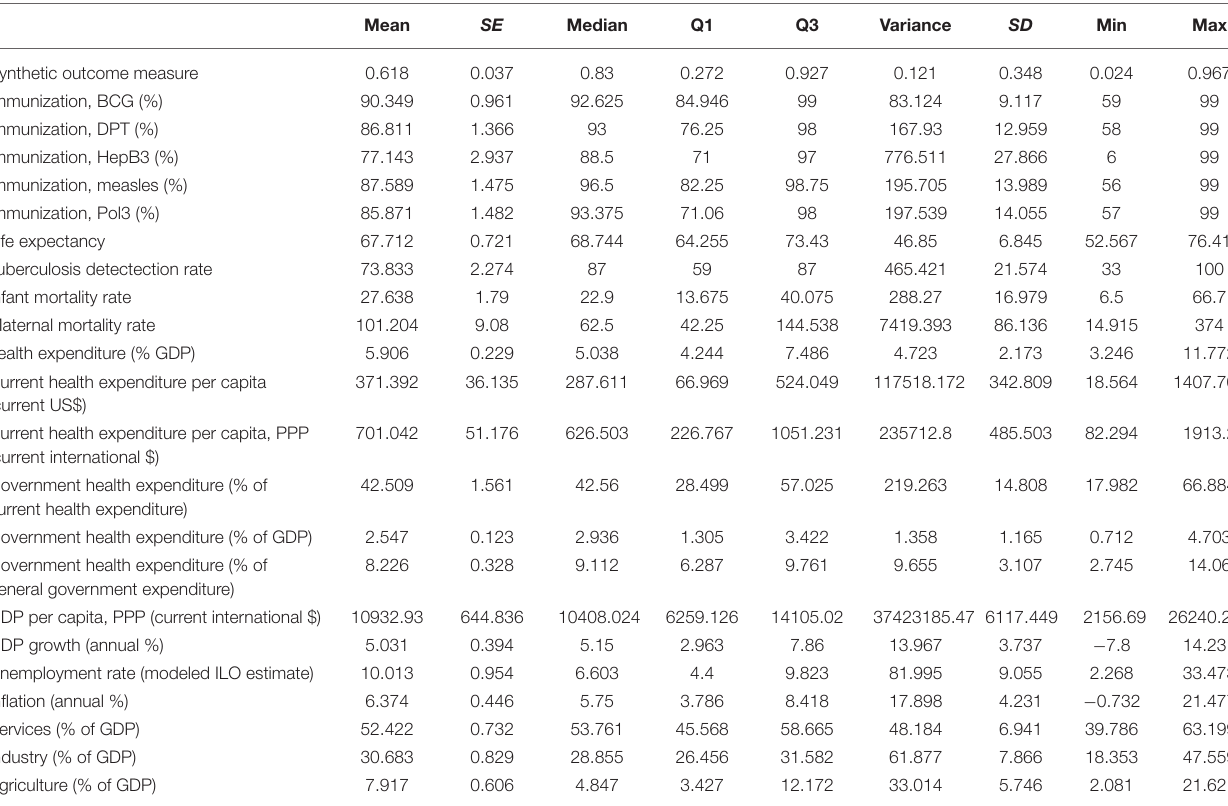
TABLE 1 | Descriptive statistics of the synthetic health system outcome measure and analyzed factors for BRICS countries in years 2000–2017. Mean SE Median Q1 Q3 Variance SD Min